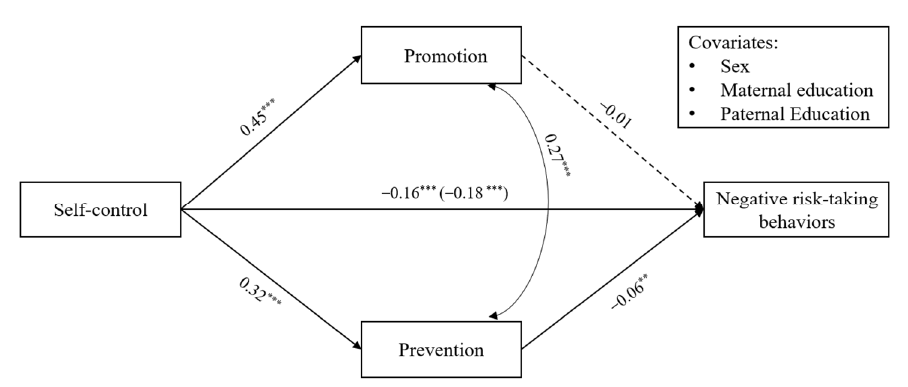
Figure 2. The mediating effect of regulatory focus in the relation between self-control and negative risk-taking behaviors. Note: Standardized estimates are presented; Values in parentheses refer to the effect without the mediator; ** p < 0.01, *** p < 0.001; Dashed line indicates a non-significant coefficient.